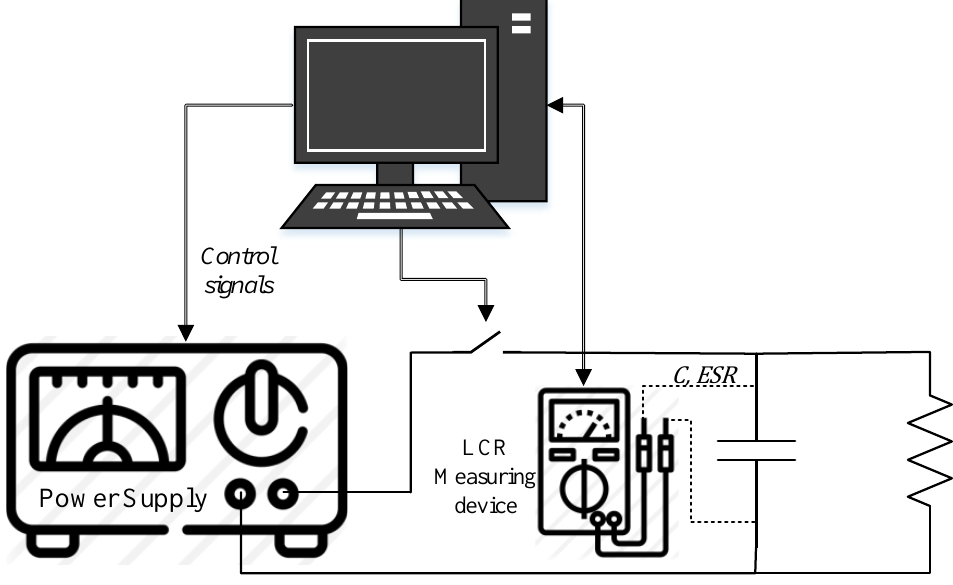
Figure 4. Accelerated aging test data acquisition system.